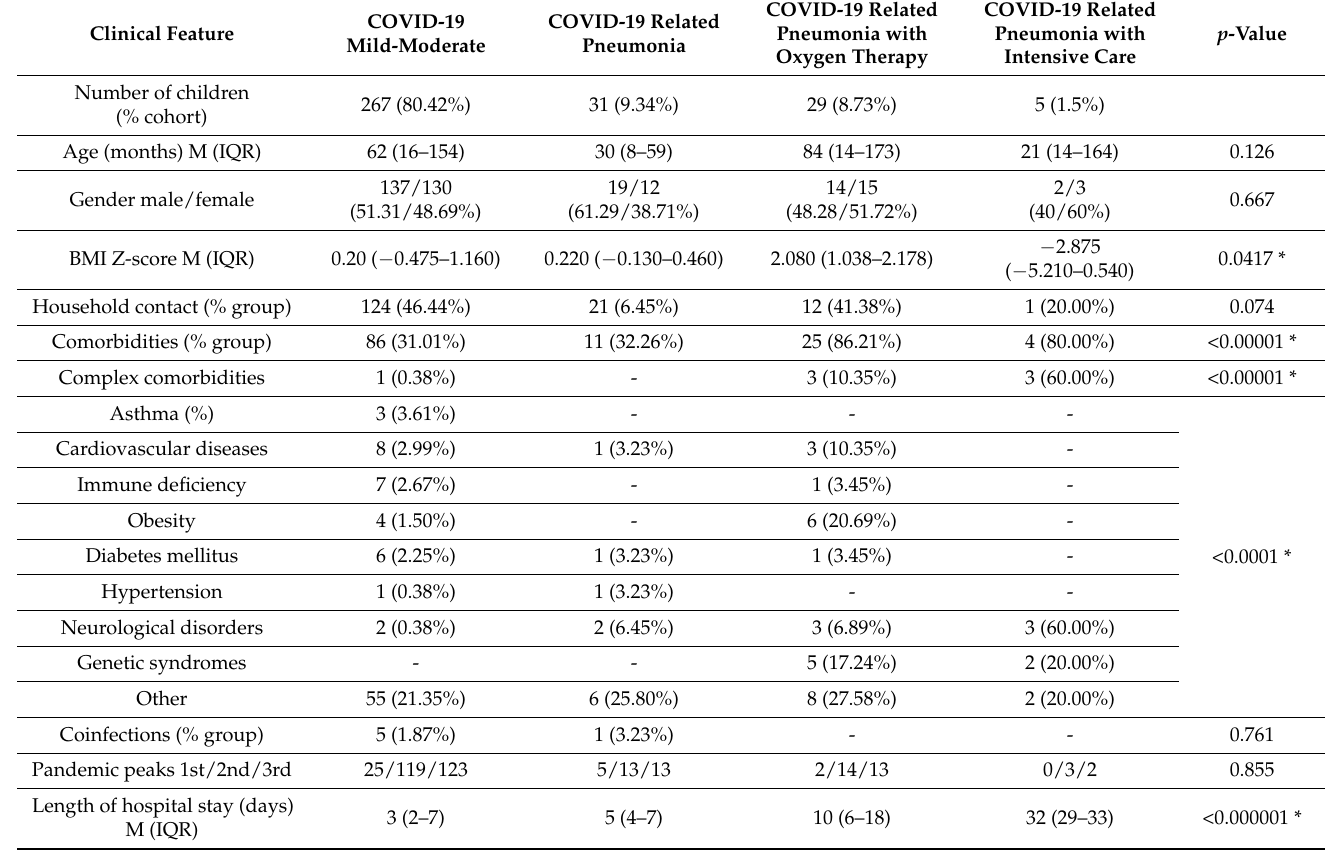
Table 1. Clinical characteristic of the study